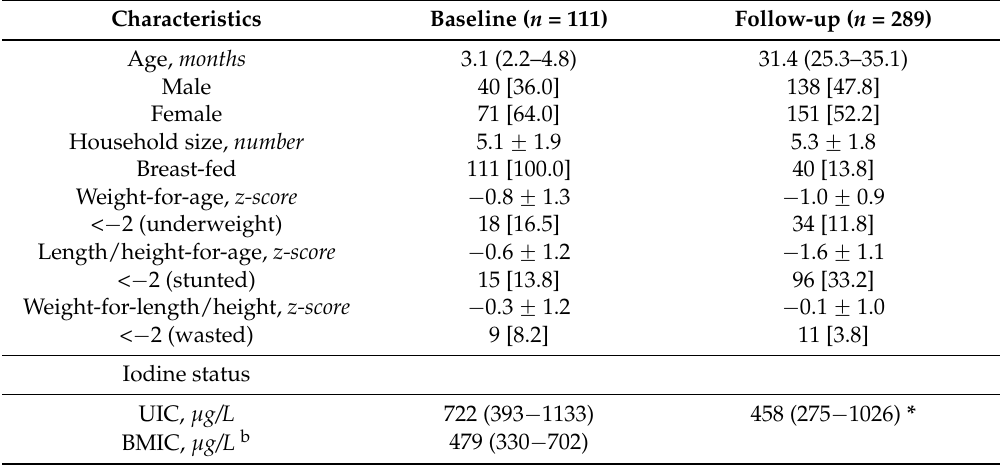
Table 2. Background characteristics and iodine status among the children at baseline and follow ‐ up a .